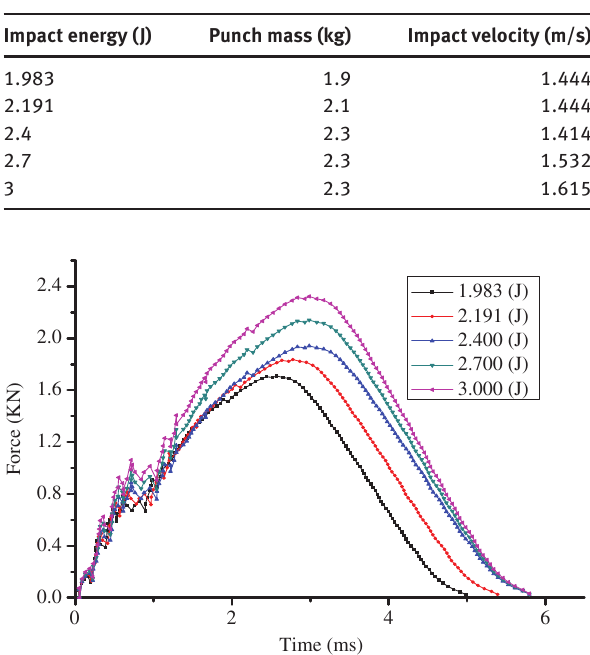
Table 5: Conditions of calculation.